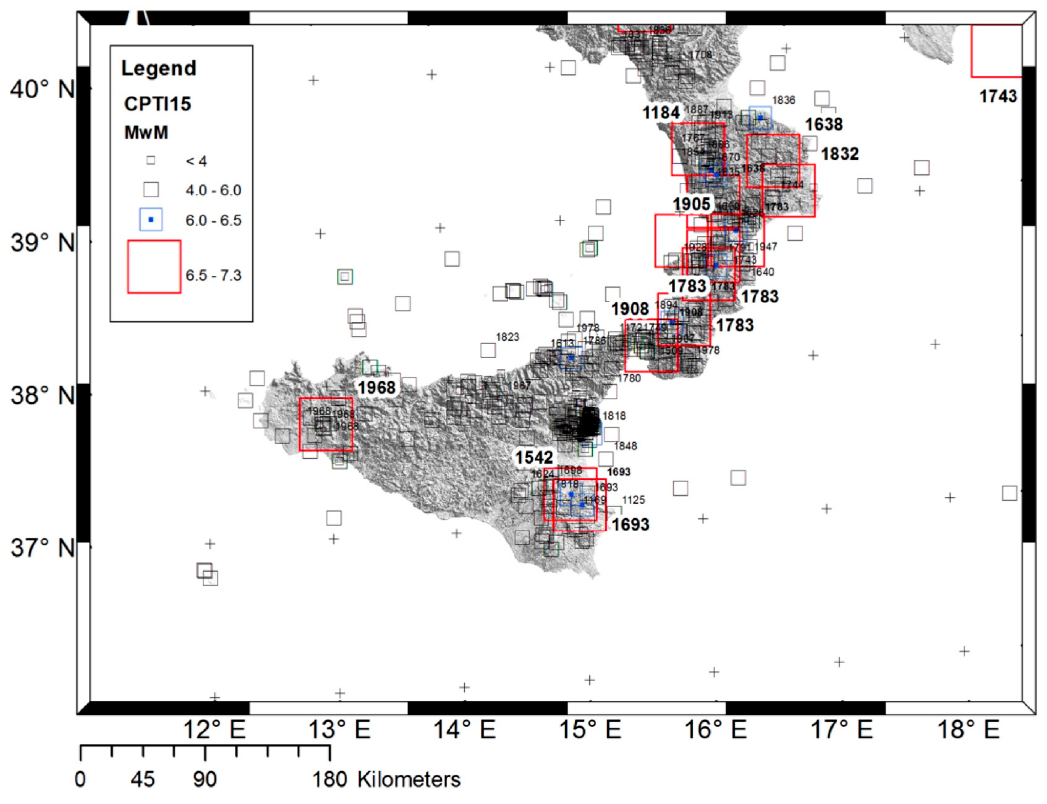
Figure 1. Historical events that have occurred in Calabria and Sicily (CPTI15, [12]). Table 1. Events that have occurred in southern Calabria and Sicily with I 0 ≥ VIII.